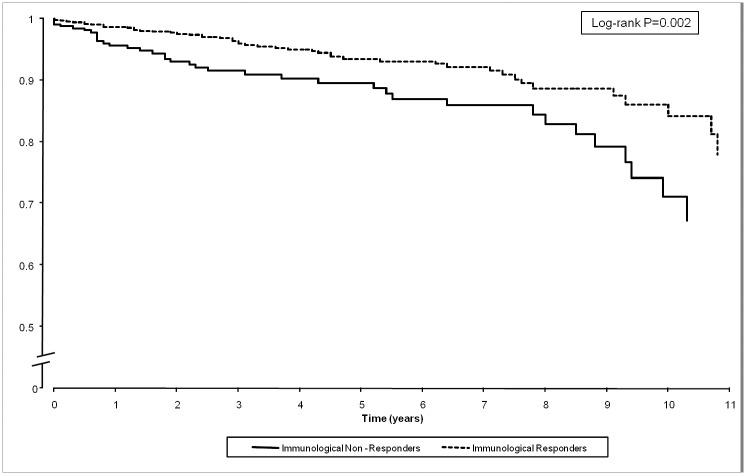
Proportion of patients remaining free from severe non AIDS-related event.List of abbreviations: AIDS, acquired immunodeficiency syndrome; HAART, Highly-active antiretroviral therapy.